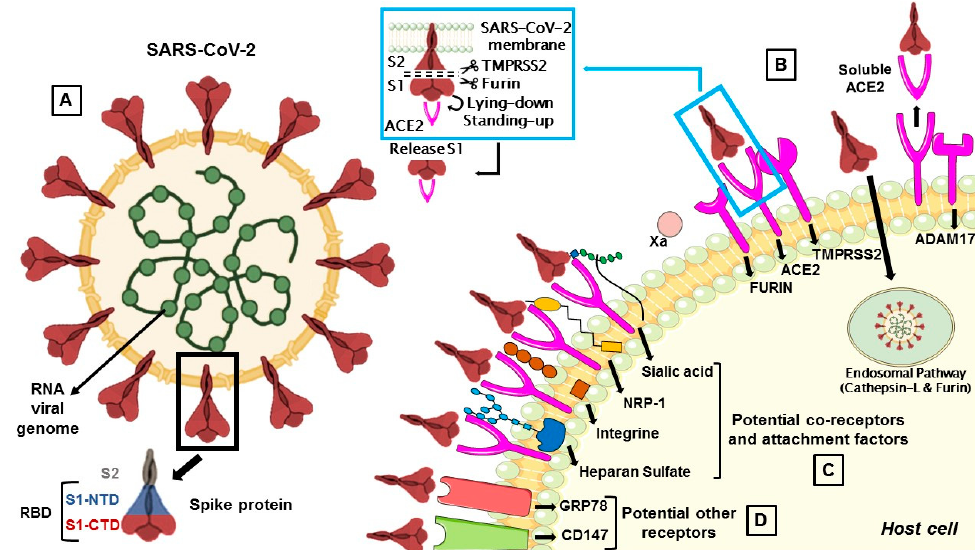
Figure 1. ( A ) The membrane spike protein of SARS-CoV-2 consists of three glycoprotein monomers, and each monomer contains two subunits, S1 and S2. The S1 subunit is divided into the N-terminal (NTD) and C-terminal (CTD) domain, which is referred to as the receptor-binding domain (RBD), while the S2 subunit contains membrane fusion activity. ( B ) SARS-CoV-2 entry mediated by TMPRSS2 and cathepsin-L. Once the S protein interacts with ACE2, TMPRSS2 cleaves S protein at the S1/S2 cleavage site and then the furin cleaves the S2 region (S2’) to initiate conformational changes for membrane fusion. The S protein can also activate ADAM17 which can cleave ACE2, resulting in shedding and soluble ACE2. In a second route, the S protein is cleaved and activated by the cathepsin-L pathway, where virions are taken up into endosomes. ( C ) Co-receptors are involved in SARS-CoV-2 attack. S proteins can recognize sialic acids, NRP-1, integrins and heparan sulfate for the first step of attachment to host cells. ( D ) CD147 and GRP78 have been identified as other potential receptors for SARS-CoV-2 entry.